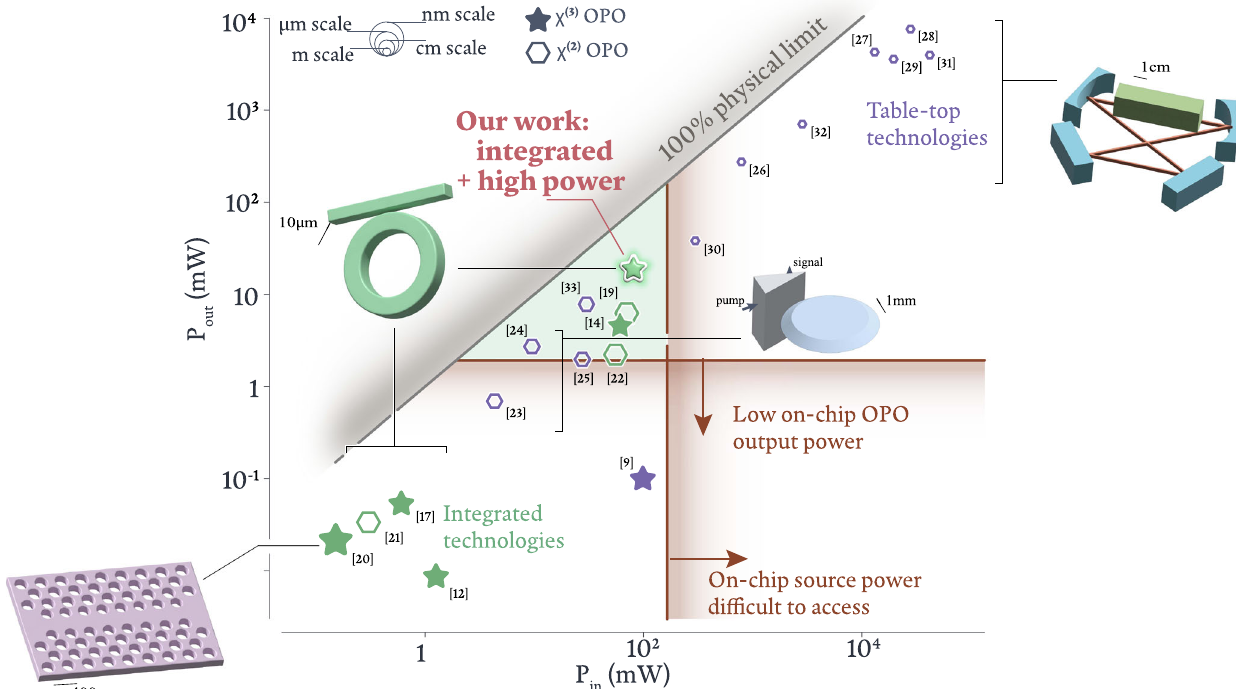
Fig. 5 | OPO performance in context. Output power vs. input power for different demonstrated OPO devices, including both integrated (green) and non-integrated (purple) technologies and both χ (3) (stars) and χ (2) (hexagons) nonlinearities. In general, integrated technologies (lower left) that have realized high conversion ef fi ciency do so at low output powers, due to factors such as a large frequency mismatch(worsenedbyKerrandthermalshifts depending on power,asdescribed in the text) or inadequate suppression of competing processes at higher powers. On the other hand, large table-top technologies (upper right) have simultaneously realized high output powers and high conversion ef fi ciencies, with the caveats of not being widely scalable, in part due to the requirement of pump powers beyond